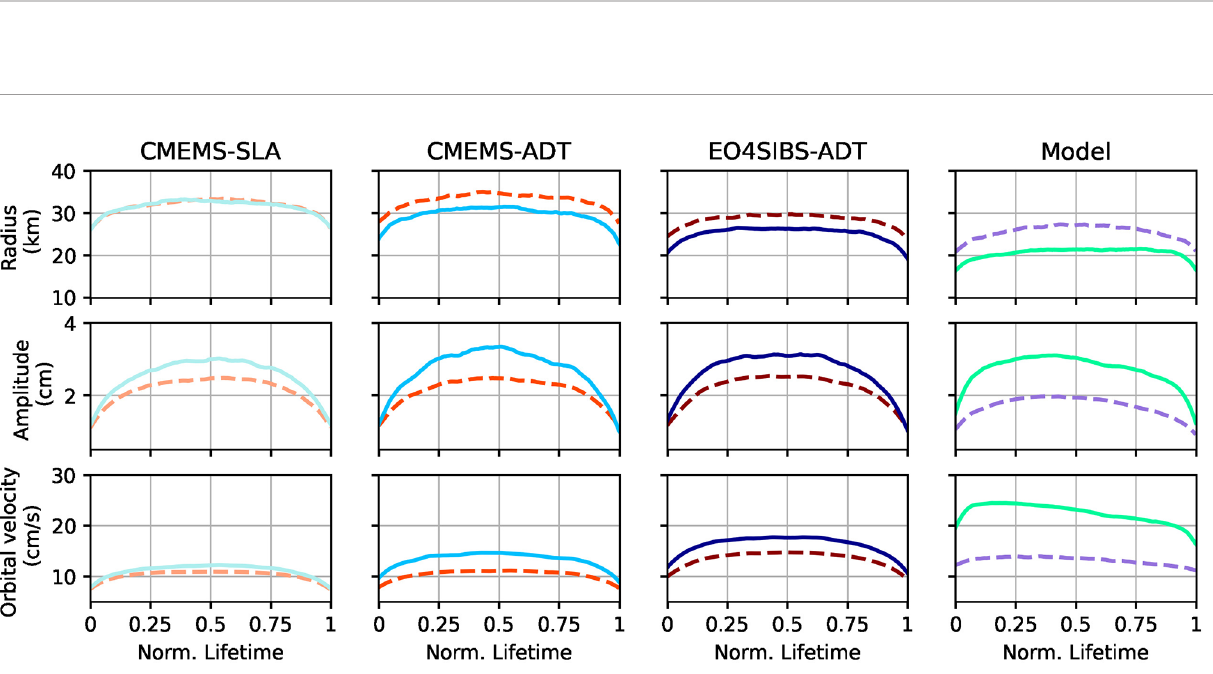
FIGURE 5 | Evolution of the average properties of (dotted lines) cyclonic and (plain lines) anticyclonic eddies along their normalized lifetime.